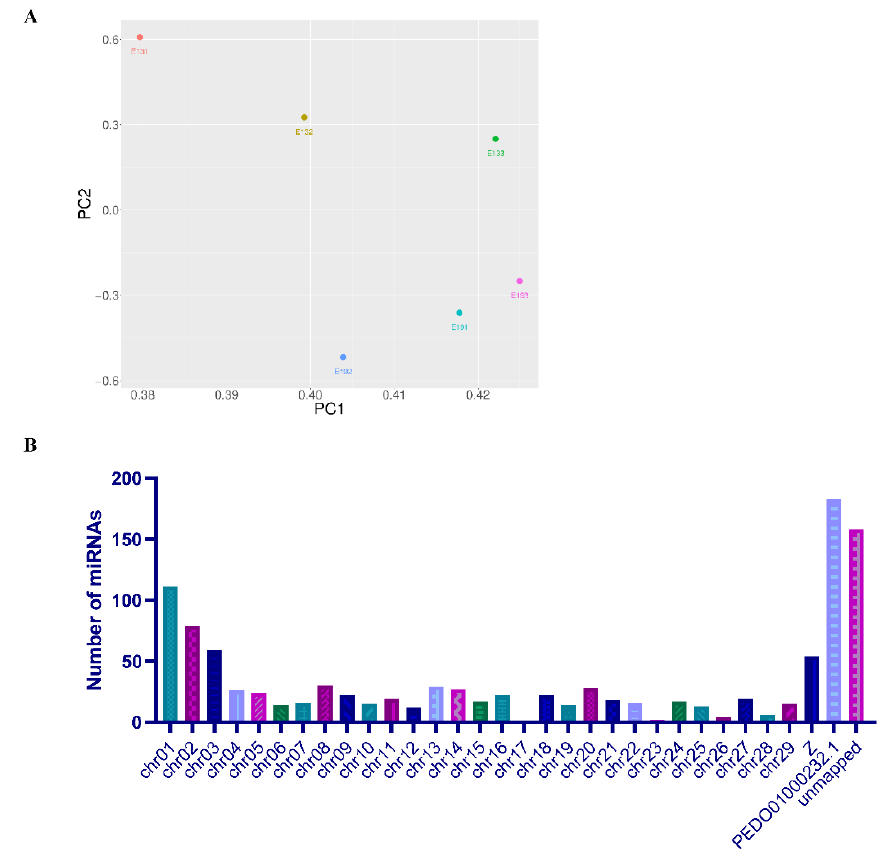
Figure 2. Component analysis of miRNAs in embryonic duck breast muscle. ( A ) PCA plot of miRNAs expressed in each sample. ( B ) Distribution of miRNAs on duck reference chromosomes.